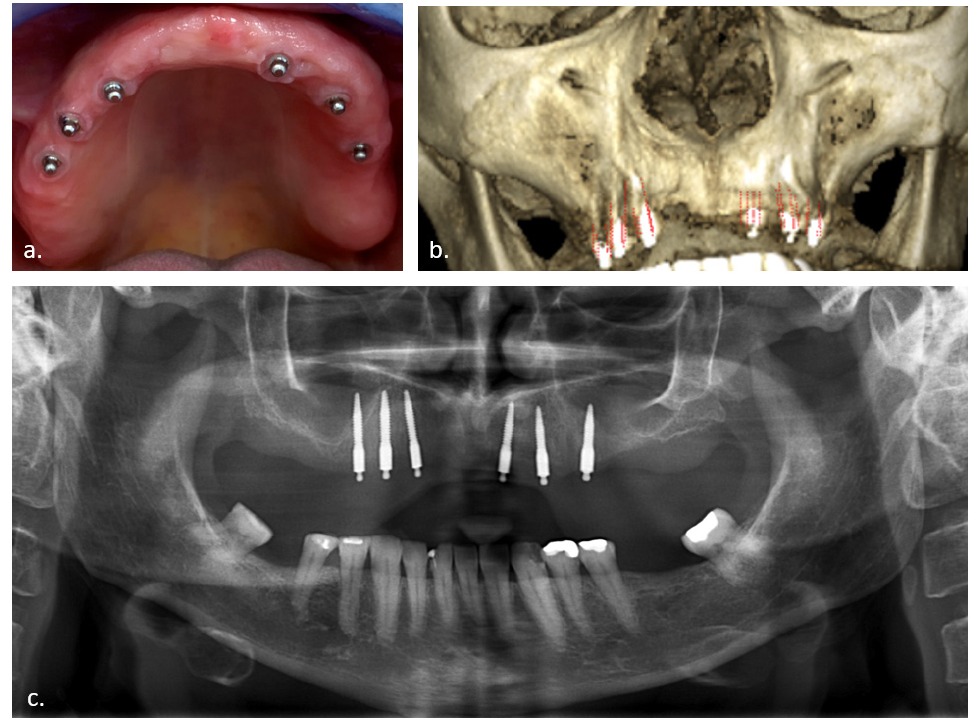
Figure 1. Case presentation: ( a ) Optimal distribution of one-piece mini dental implants (MDI) in the edentulous maxilla; ( b ) CBCT 3D presentation; ( c ) Panoramic 2D X-ray with posterior MDI perforation of the maxillary sinus.